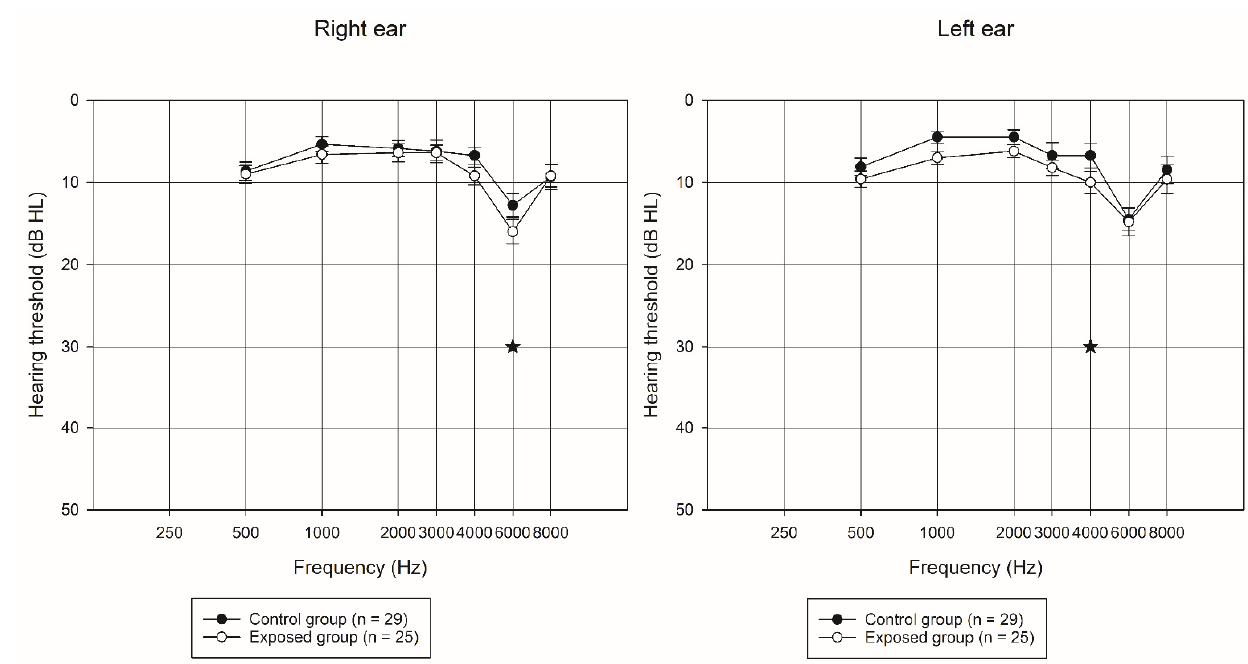
Figure 3. Mean hearing thresholds (+/ − one standard error) by ear and exposure group. Star symbol denotes significant differences at the p < 0.05 level between study